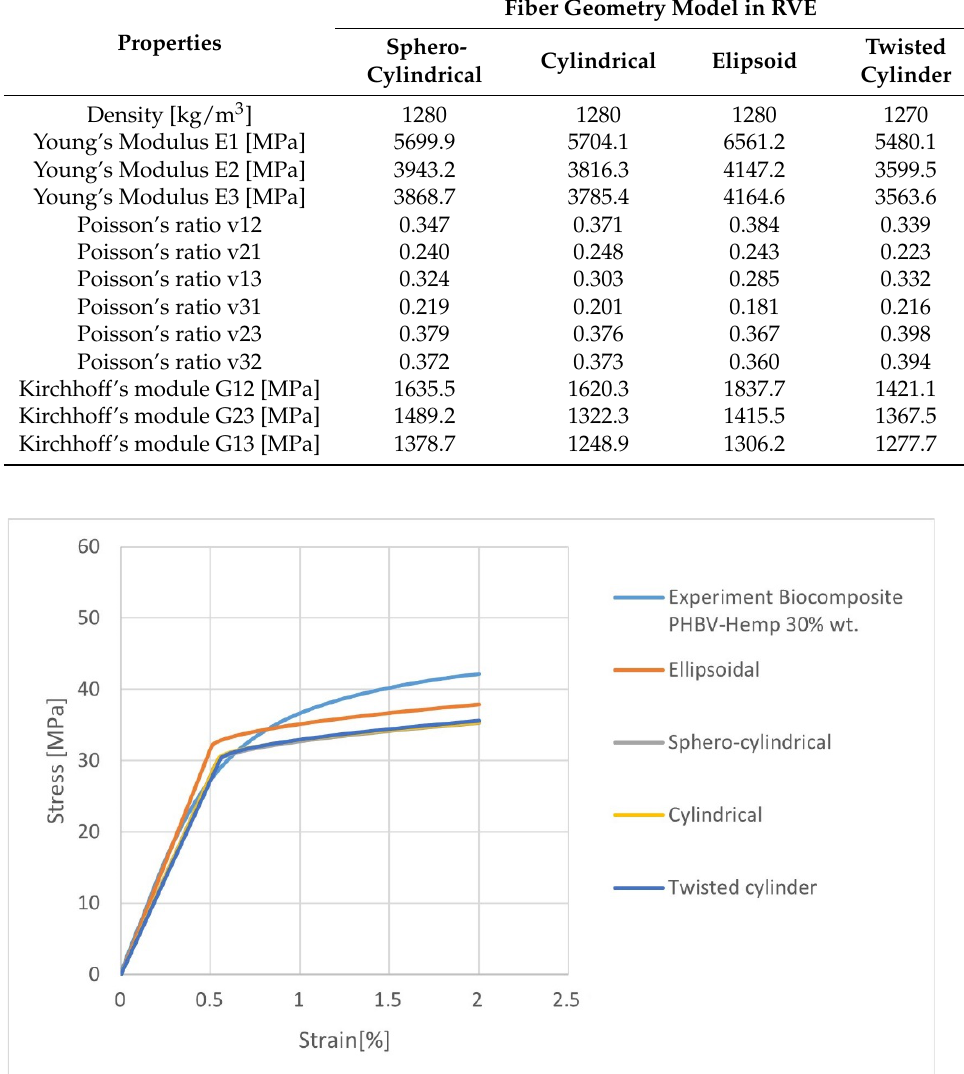
Table 9. The predicted properties of the biocomposite PHBV-hemp fiber for variable types fiber geometry in RVE.